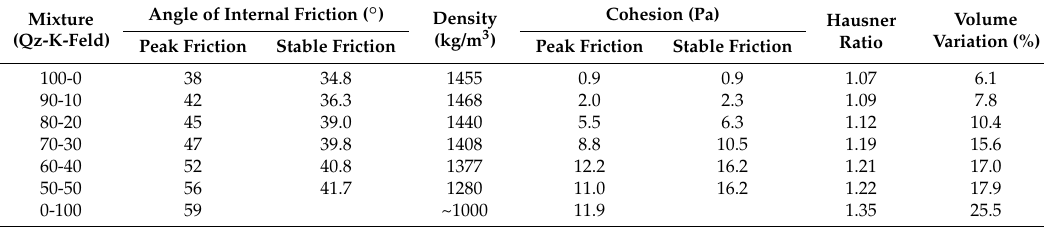
Table 7. Main parameters obtained through empirical methods for the different sand mixtures. Mixture